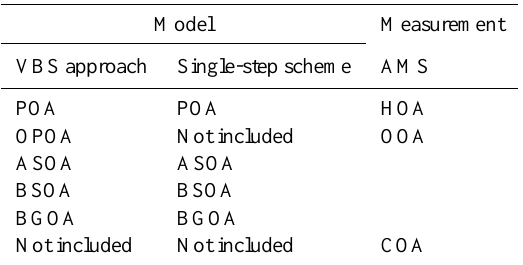
Fig. 13. OOA observed/SOA simulated ratio for clean (R4) and polluted (R1, R2, R3) periods at LHVP; boxplot for 25, 50 and 75 Fig. 13 OOA observed / SOA simulated ratio for clean (R4) and polluted (R1, R2, R3) periods at LHVP; percentiles, and extreme values. boxplot for 25, 50 and 75 percentiles, and extreme values. Table 3. Corresponding OA components in simulations and mea-